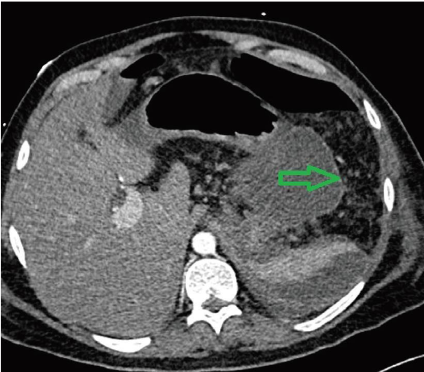
Figure 1: Computed tomography of the abdomen and pelvis showing necrotizing pancreatitis (green